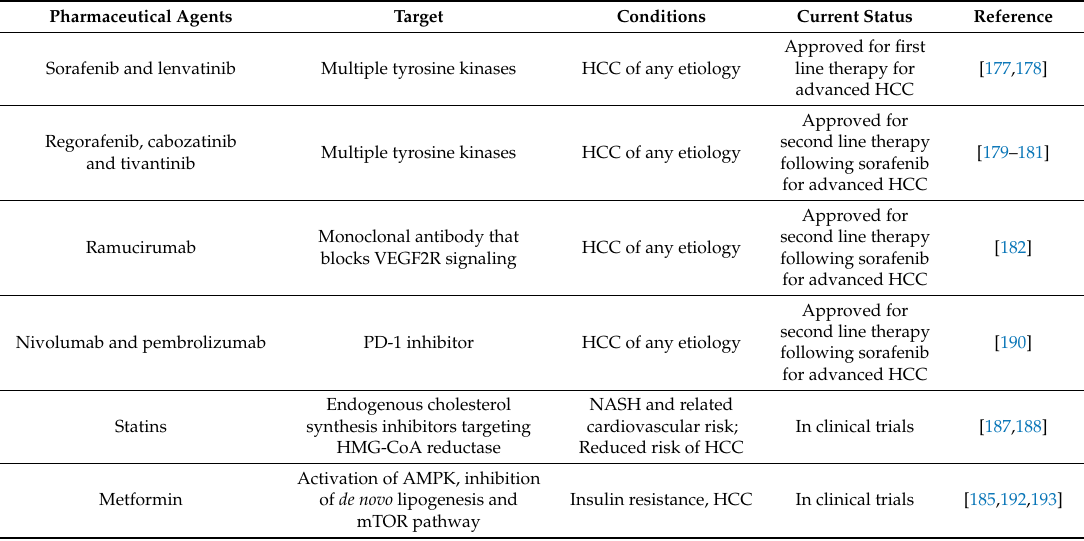
Table 1. Differentpharmaco-therapeuticagentsemployedinobesity-associatedhepatocellularcarcinoma(HCC). Pharmaceutical